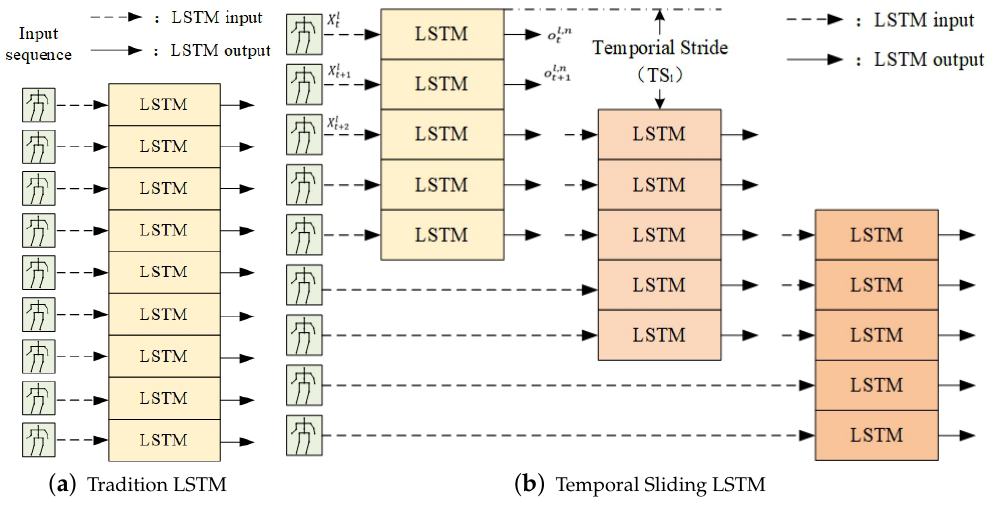
Figure 3. Comparison of the structures between straightforward LSTM and TS-LSTM. ( a ) shows the structure of the straightforward LSTM. ( b ) shows the conceptual diagram to illustrate the structure of the l th TS-LSTM when N l = 3, W l = 5, and TS l =